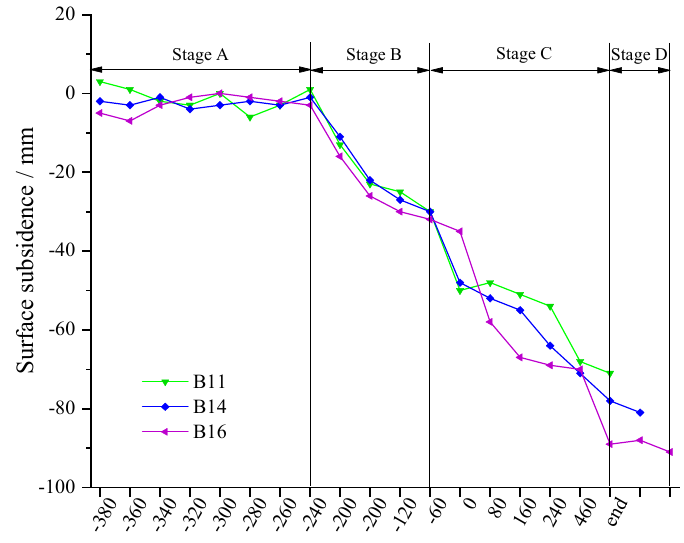
Distance between working face and measuring point / m Figure 16. Advanced impact stage Figure 16. Advanced impact stage division. Figure 16. Advanced impact stage division.